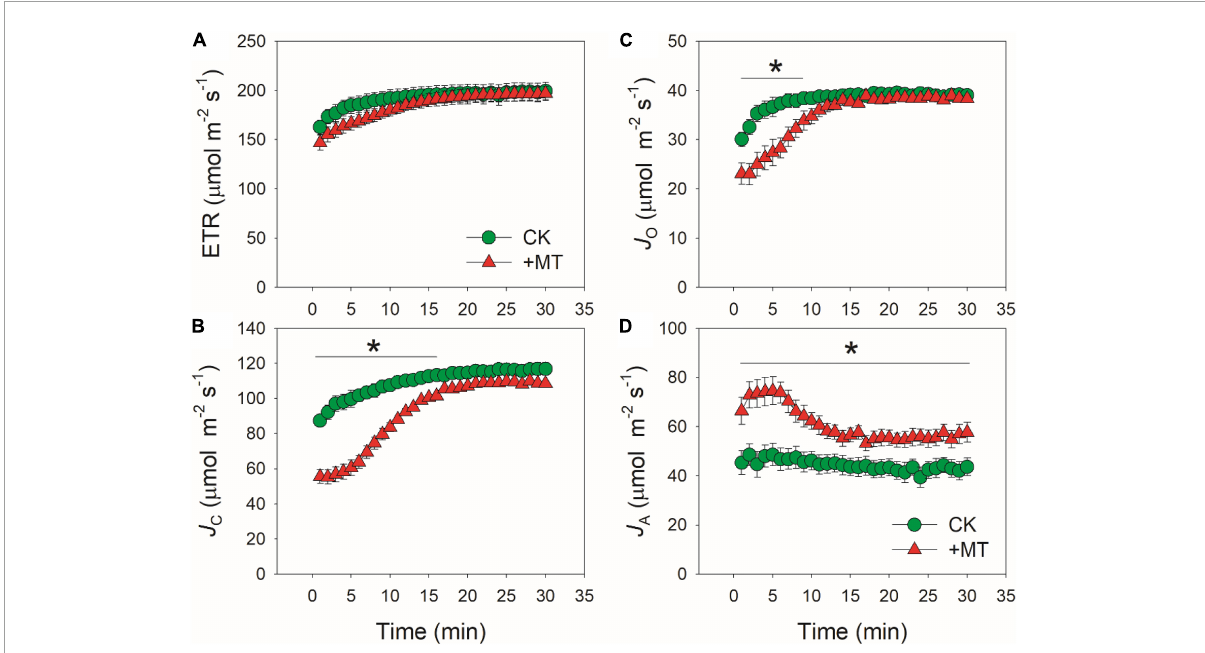
FIGURE6 Effects of exogenous melatonin (MT, 100 µ M) on the induction response of total electron transport rate (ETR) (A) , electron flow for Rubisco carboxylation (JC) (B) , electron flow for Rubisco oxygenation (JO) (C) , and alternative electron sinks (JA) (D) after transition from 50